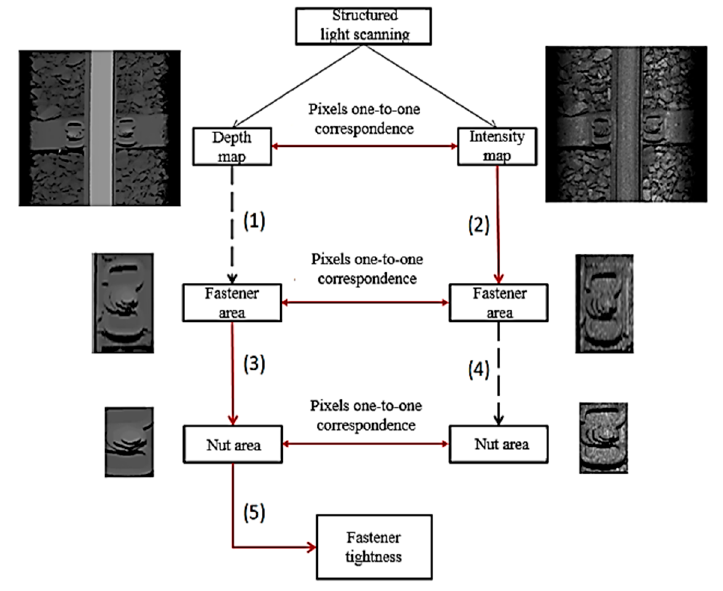
Figure 3. Method for detecting nut position based on 2D/3D map. The black dotted arrows in the figure indicate the methods with poor experimental